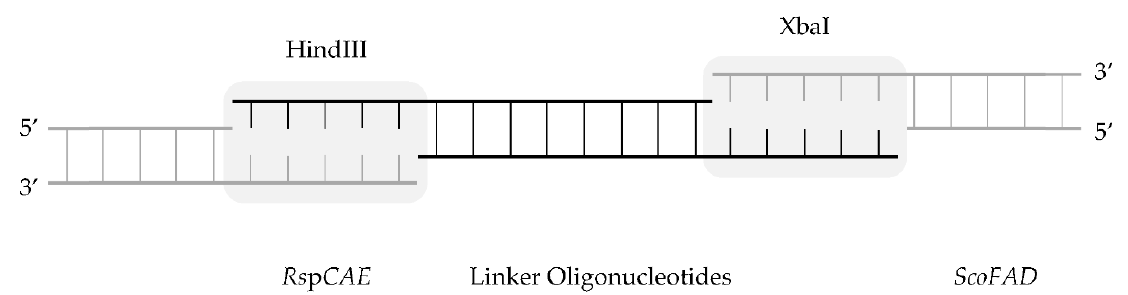
Figure 7. Scheme of the ligation-based linker cloning strategy. Two overlapping oligonucleotides coding for the linker sequences and including overlapping ends complementary to HindIII and XbaI restriction sites were used along with the digested genes in a ligation step.